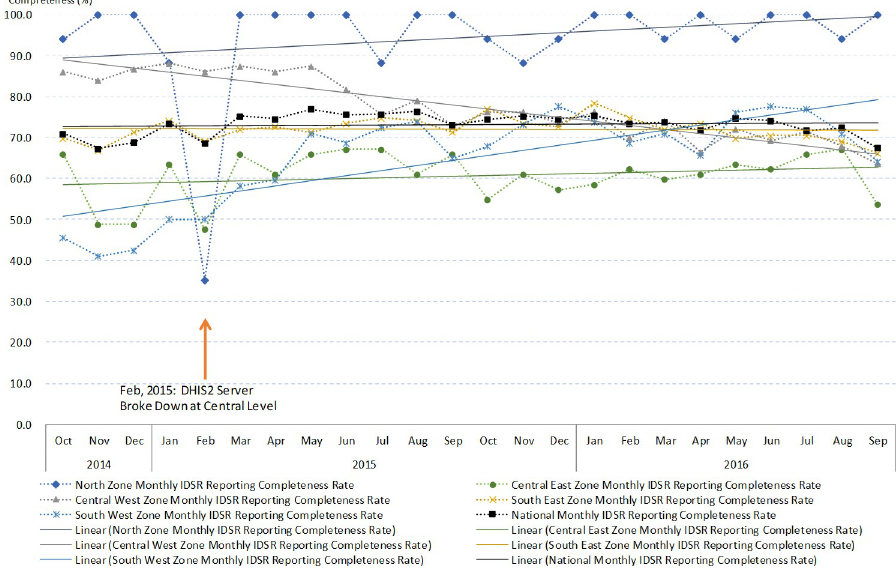
Fig 2. The IDSR monthly reports completeness indicator from October 2014 to September 2016 divided by zones and national level.